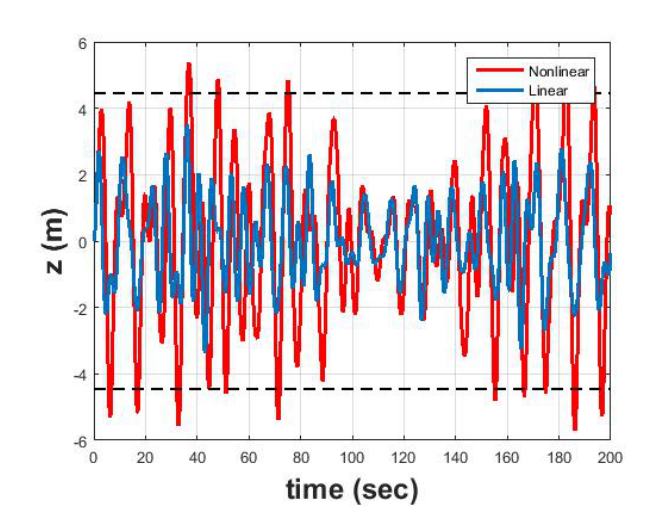
Figure 18. Comparison between the linear and nonlinear WECs in irregular waves: buoy position.